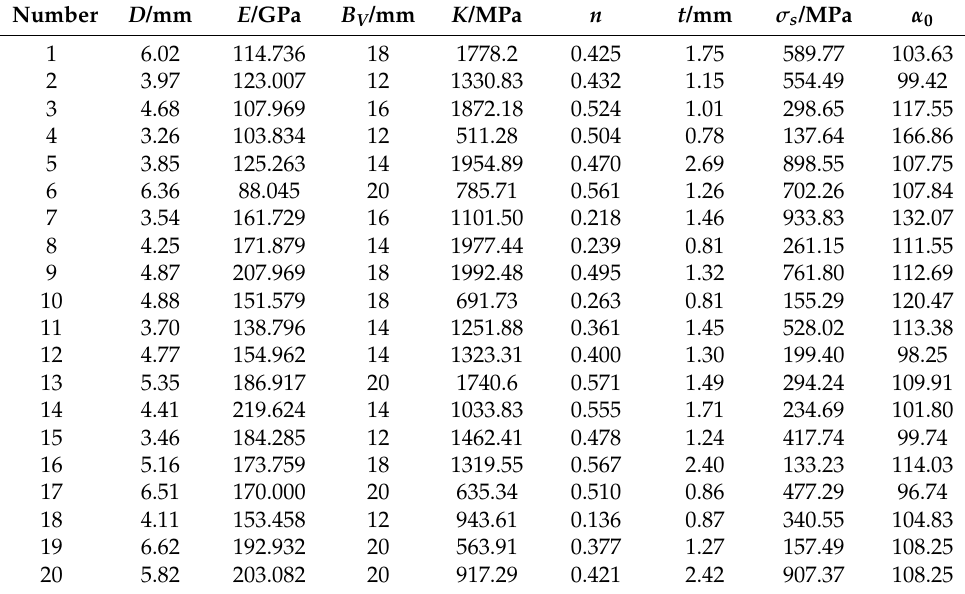
Table 3. Testing samples from the simulation